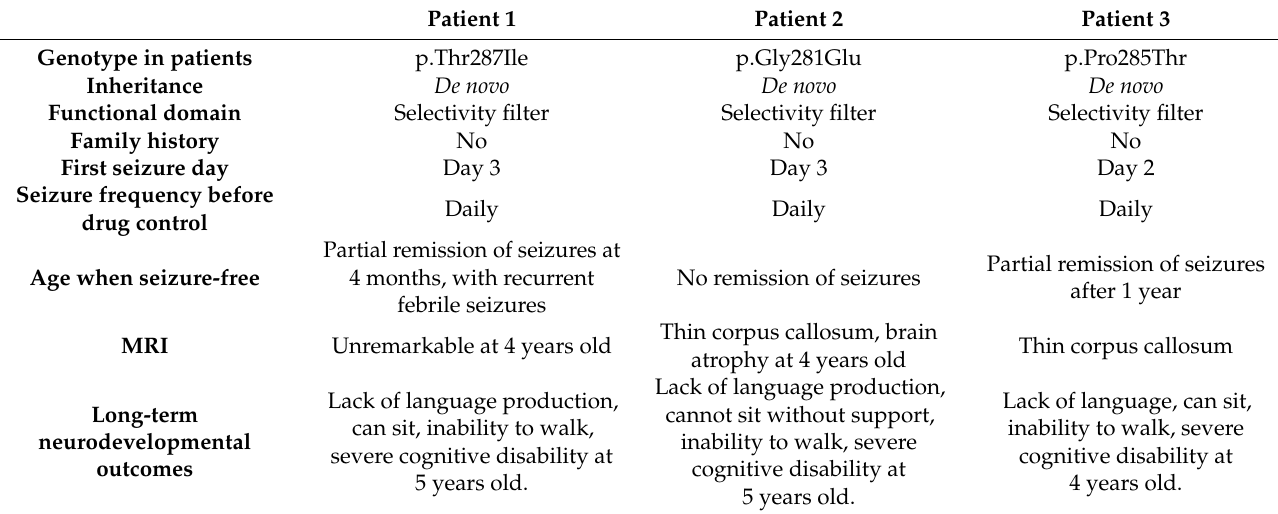
Table 1. Clinical presentations and long-term neurodevelopmental outcomes in three KCNQ2 muta- tions located in SF